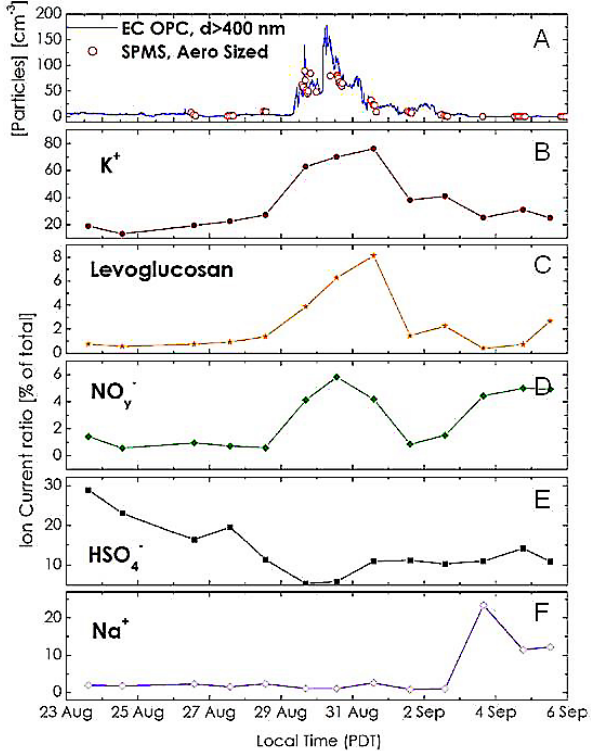
Fig. 6. (A) Time Series of total particle concentration for particles larger than 400nm as measured by the EC OPC and the UBC SPMS at Whistler Peak during the week before and after the smoke event. (B–F) Time series of relative intensity of potassium, levoglucosan, nitrate, sulphate and sodium over the same time